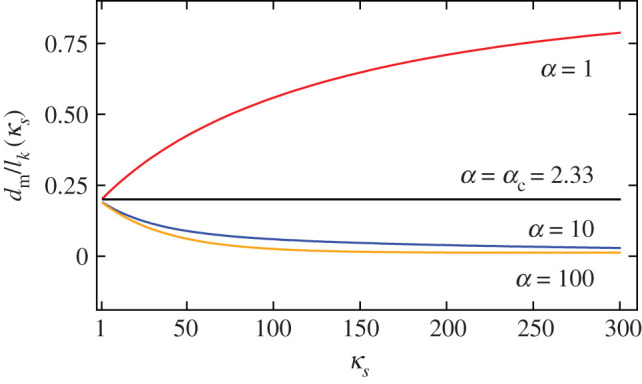
Critical thickness of the SL system as a function of κs for several values of α. Each value of d is scaled by the appropriate Kittel length.